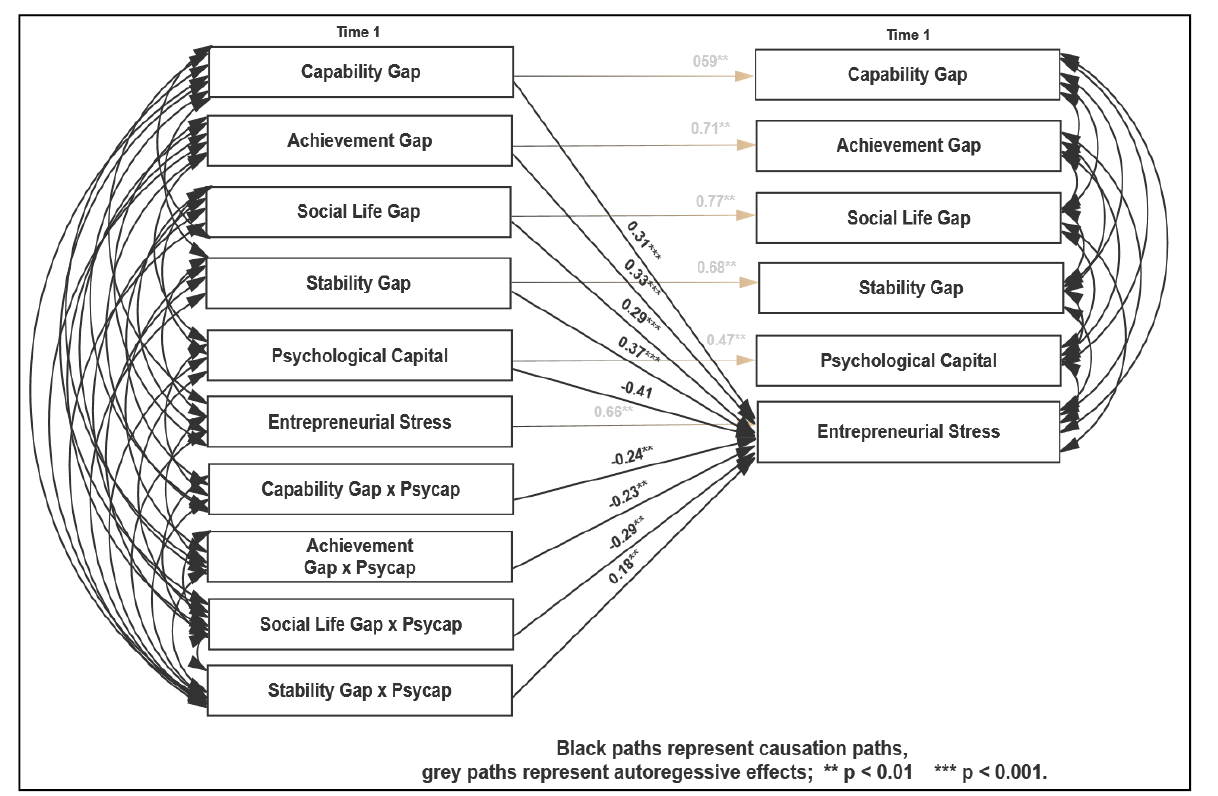
Figure 2. Parameter Estimates of Moderation Model (lagged effects).